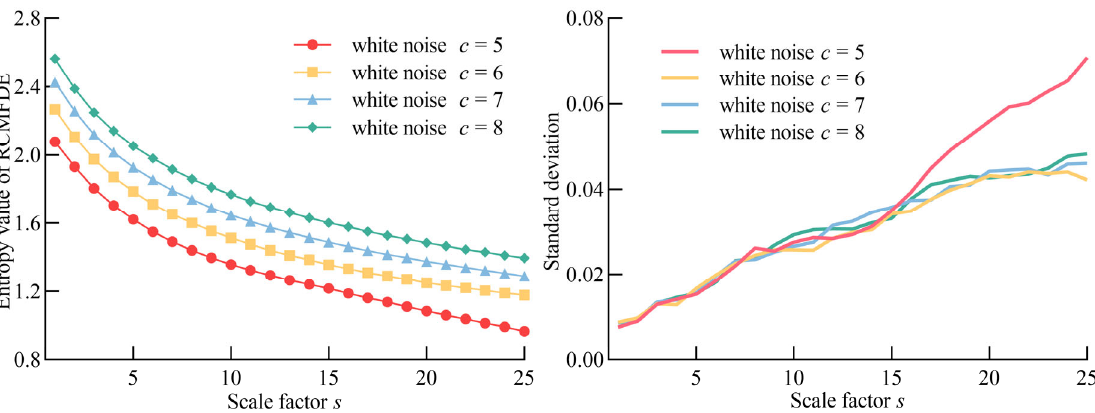
Figure 5. Effect of parameter c on RCMFDE.